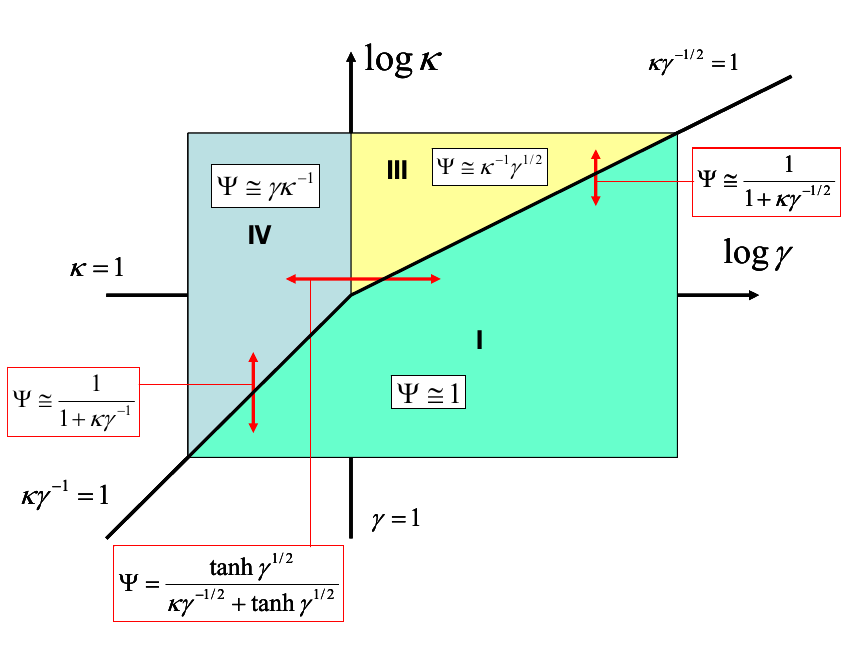
Figure 9. Kinetic case diagram (plot of log κ versus log γ ) for membrane bound direct reaction and diffusion of electro-enzyme . Note that κ compares the rate of enzyme regeneration at the electrode with that of enzyme diffusion through the solution, whereas γ compares the rate of enzyme diffusion to that of homogeneous reaction between enzyme and substrate. In both cases approximate limiting expressions for the normalized flux and the expressions delineating the boundaries between specific cases are